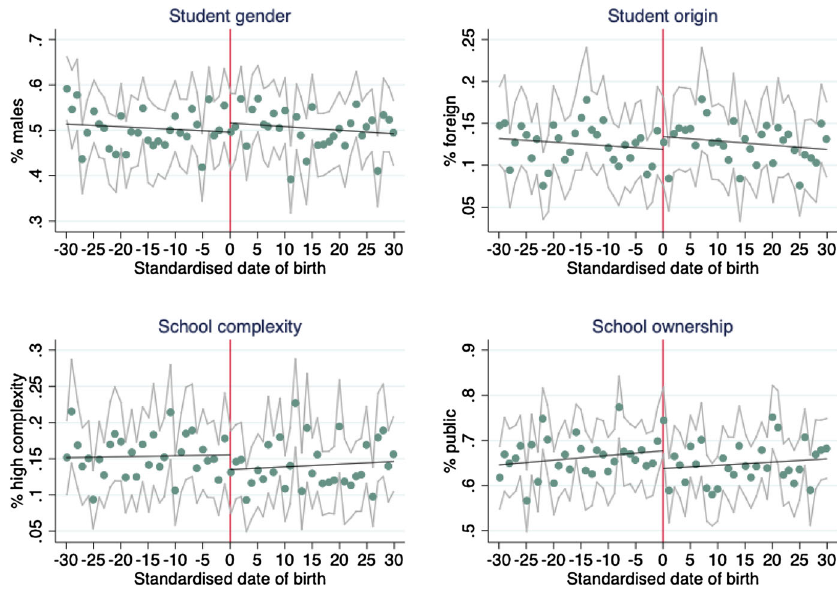
Fig. 1 Continuity test RD plots, 2007 cohort